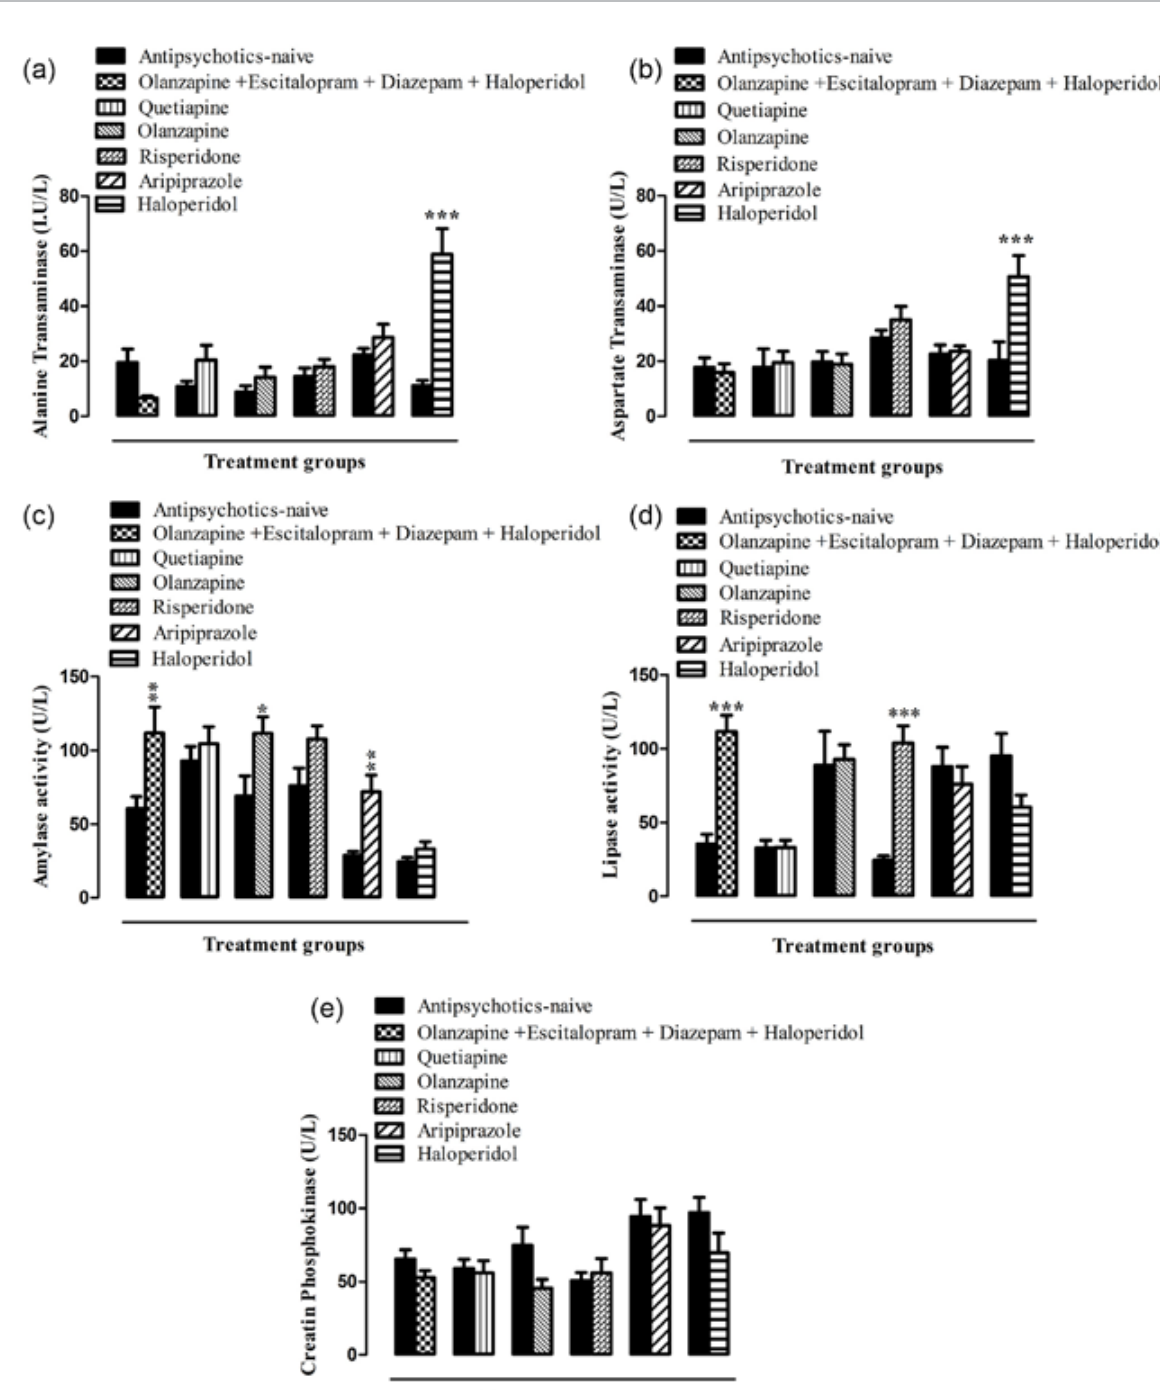
FIGURE 9 - Effect of selected antipsychotics on enzymes: Antipsychotic-naïve patients were treated with olanzapine in combination with escitalopram, diazepam (STAT, I.V) and haloperidol (STAT, I.M) (OLEDH, n=8), or quetiapine (QUET, n=8), olanzapine (OLAN, n=8), risperidone (RISP, n=8), aripiprazole (n=8) or haloperidol (n=8) in therapeutic doses for an average time period of 39, 40, 45, 38, 30 and 33 days respectively showing significant elevation in ALT (a) and AST (b) in haloperidol treated groups as compared to antipsychotics-naive, significant elevation in amylase (c) of combination group (**P < 0.01), olanzapine (*P < 0.05) and aripiprazole treated groups (**P < 0.01) as compared to antipsychotics-naïve patients. Significant elevation was observed in lipase (d) of combination group (***P < 0.001) and risperidone treated group (***P < 0.01) as compared to antipsychotics-naïve patients. No significant change in CPK (e) as compared to antipsychotics-naïve patients was noticed (P > 0.05) (ANOVA followed by Bonferroni’s Multiple Comparison